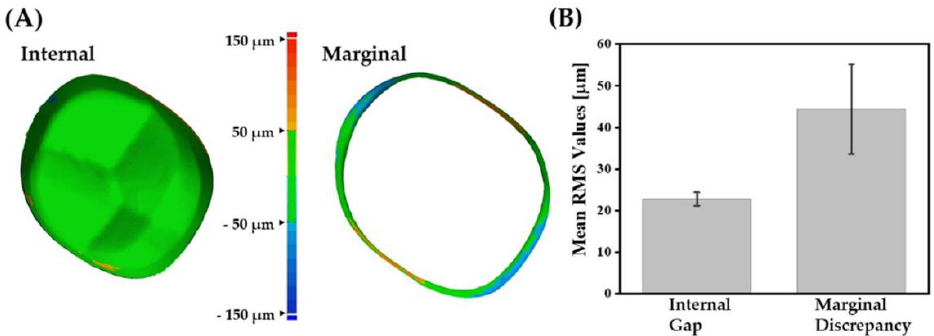
Figure 17. ( A ) Representative color maps generated by superimposition of scanned data of a 5Y-PSZ dental crown and original CAD data and ( B ) measured mean RMS values for marginal discrepancy and internal gap.